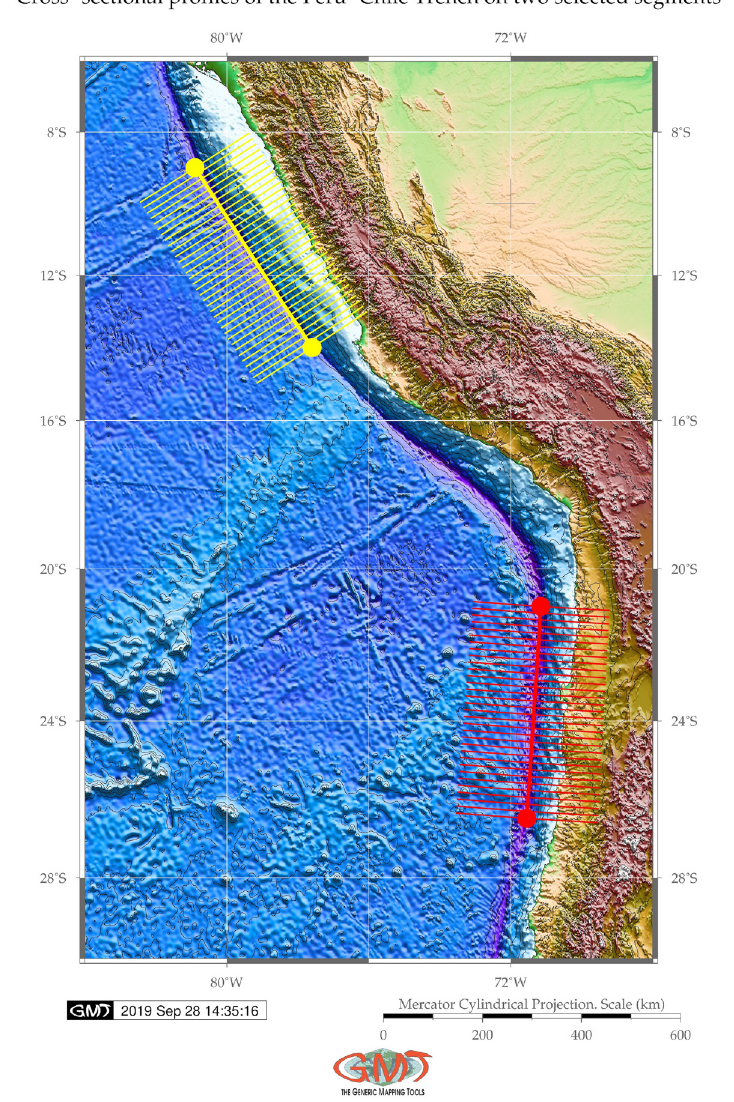
Fig. 5. Two segments with digitized profiles: Peruvian (north) and Chilean